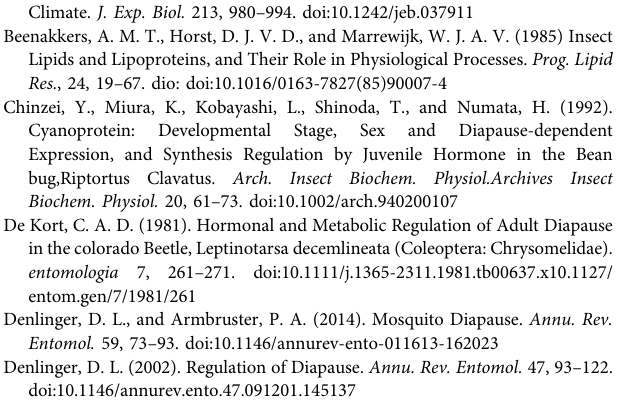
Supplementary Table S2 | Juvenile hormone concentration after dsRNA